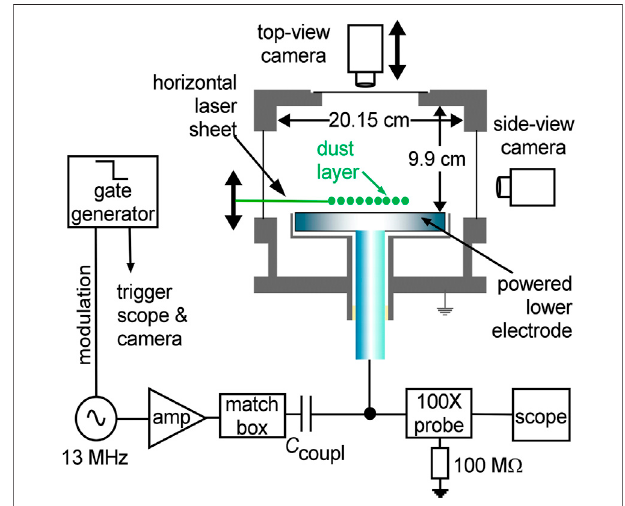
FIGURE1 | Side-viewsketch ofthe experimental setup. A single layer of microsphereswaslevitatedabovethelowerelectrode,whichwaspoweredby a radio-frequency waveform. The plasma power was switched off at t = 0 by modulatingthe13 MHz oscillatorsignalusingthegategenerator.During the subsequent afterglow, the capacitor C coupl maintained a negative bias on the lower electrode. A top-view camera, for viewing the 2D structure, was mounted on a vertical translation stage, so that the camera could be repositioned at a different height. To illuminate the microspheres, two laser sheetswereused:ahorizontal sheetat532 nm(producedbyopticsmounted onaverticaltranslationstage)andaverticalsheetat671 nm(notshownhere).